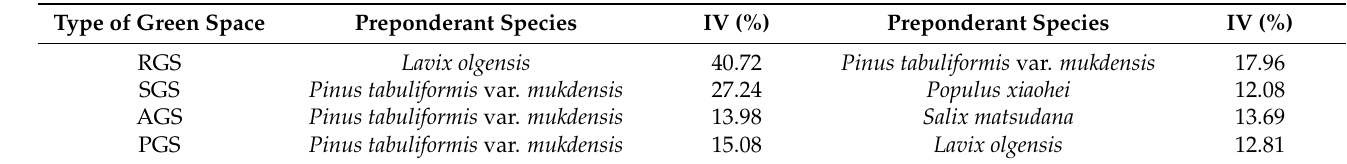
Table 3. Two preponderant species of middle-aged trees by type of green spaces in Changchun city. RGS, road green spaces; SGS, square green spaces; AGS, attached green spaces; PGS, park green spaces.